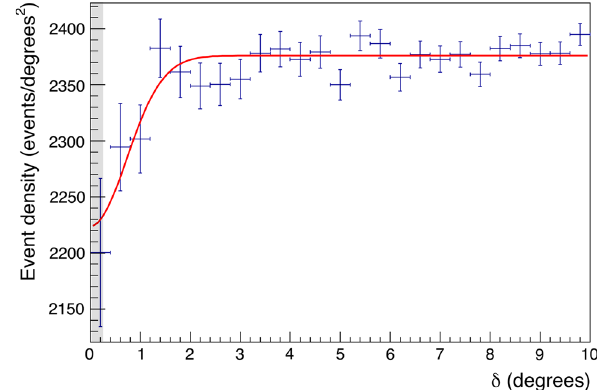
Fig. 2 Theteststatistics λ distributionforthe“Moonshadow” hypoth- esis H 1 (dotted curve) and the “no Moon shadow” hypothesis H 0 (smooth curve). The dashed area corresponds to the 50% of the pseudo- experiments where the Moon shadow hypothesis is correctly identi- fied. The shaded area quantifies the expected median significance (here 3 . 4 σ ) to observe the Moon shadow